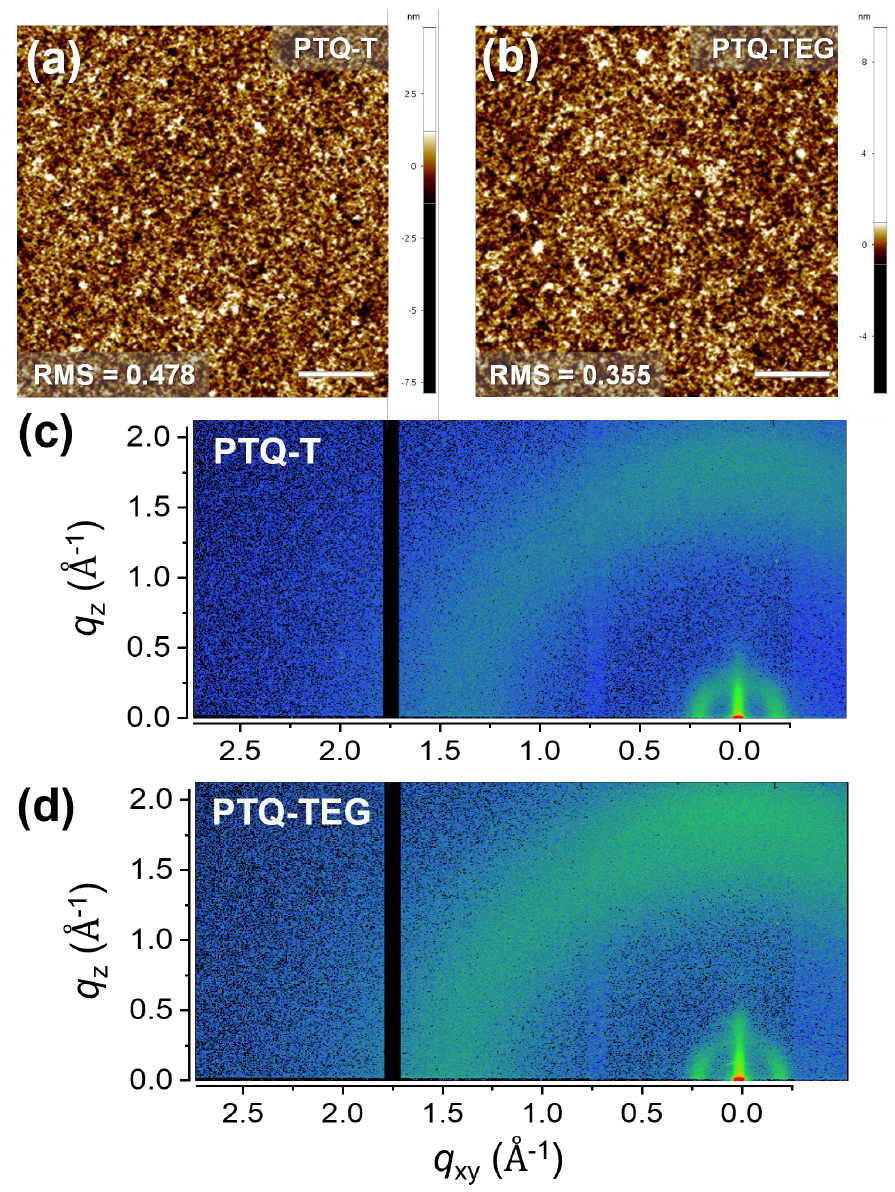
Figure 3. Surface morphologies and chain assembly tendencies characterized using AFM and 2D- GIXRD for ( a , c ) PTQ-T and ( b , d ) PTQ-TEG . To confirm whether the difference in the electrical properties of PTQ-T and PTQ-TEG present in the CPs were analyzed using XPS. As shown in Figure 4, when the